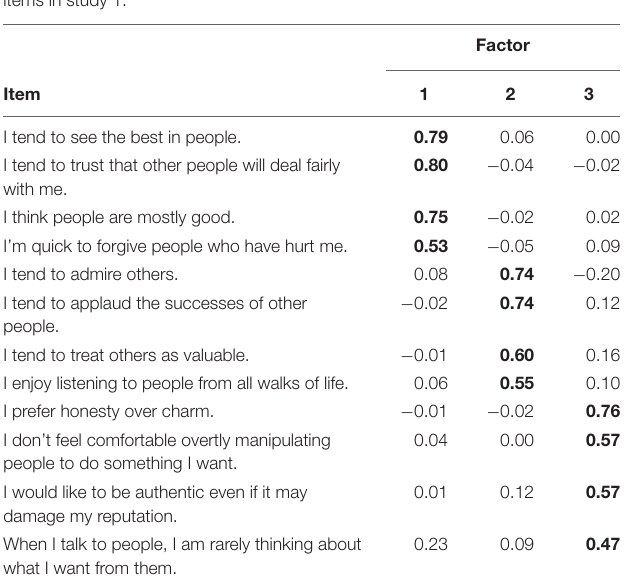
TABLE 3 | Exploratory factor analysis loadings from select 12 light triad items in study 1.